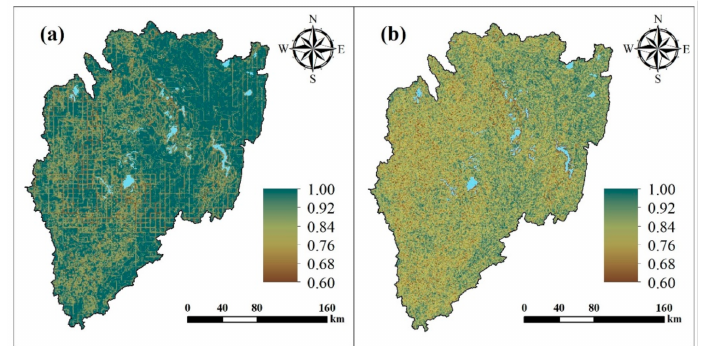
Figure 7. Grey relation grade map of ( a ) climate change and ( b ) human influence. The grey relation grade is calculated according to the AMD0 and AMD1 scales. Over the AMD0 scale, the grey relation grade of climate change for the four countries that make up the basin decreases, with values of 0.99, 0.98, 0.94, and 0.94 for Tanzania, Uganda, Rwanda, and Burundi, respectively. The grey relation grade of human influence also shows a decreasing trend of 0.86, 0.83, 0.83, and 0.81 for Tanzania, Uganda, Burundi, and Rwanda, which are 0.86, 0.83, 0.83, and 0.81, respectively. In terms of their spatial distribution, both factors appear to decrease from the northeast to the southwest. Over the AMD1 scale (Figure 8), the change trends are the same as for AMD0 scale, where the grey relation grade for climate change has the largest (0.88) and the smallest (0.80) in Bukoba Rural (Tanzania) and Mwaro (Burundi), respectively. The maximum (0.99) and minimum (0.90) of the grey relation grade for human influence appeared in Ngara (Tanzania) and Muyinga (Burundi),